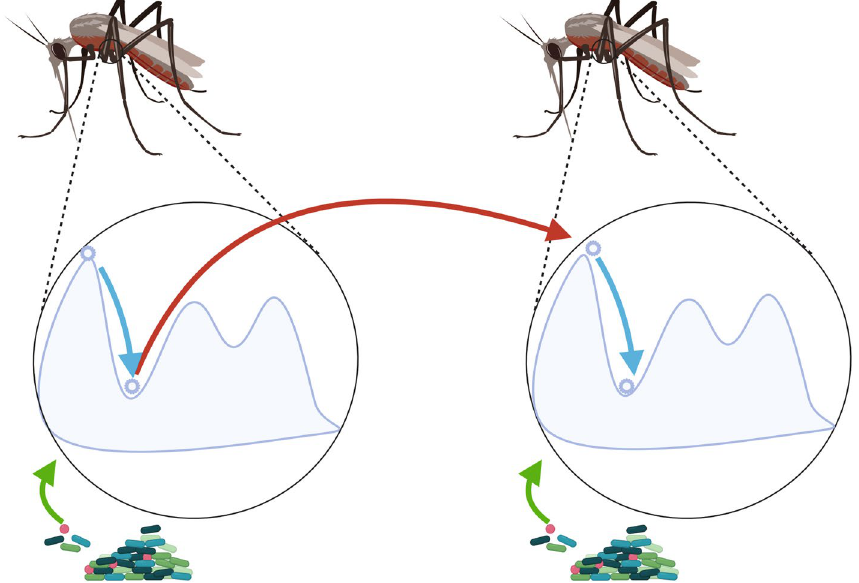
Figure 6. A mechanism for the “It’s the song, not the singer” theory applied to holobionts, created with biorender (https:// biore nder. com/). The vertically transmitted microbiota initiates an ecological succession in the functional space, which requires the arrival of horizontally transmitted symbionts. The final stable state reached is the same as in the previous generation, which implies the conservation of the functional composition across